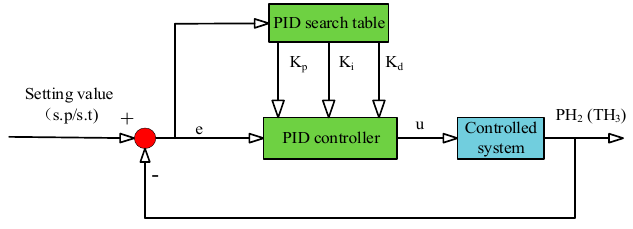
Figure 3. Schematic diagram of the